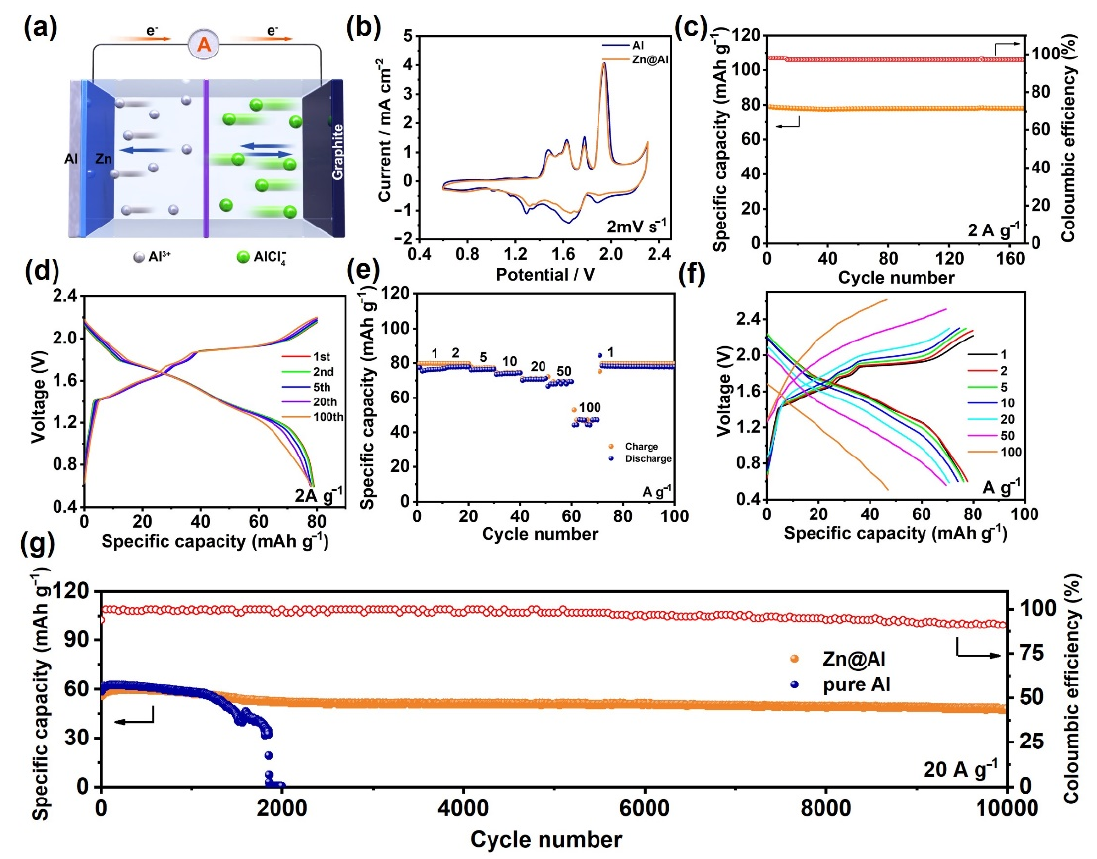
Figure 3. Electrochemical performances of Zn@Al–graphite and Al–graphite cells: ( a ) Working diagram of full battery. ( b ) CV curves in full battery at a scan rate of 2 mV·s − 1 . ( c ) Cycling stability ( d ) and charge/discharge curves of Zn@Al–graphite full battery at 2 A·g − 1 . ( e ) Rate performance and ( f ) charge/discharge curves of Zn@Al–graphite cell at various currents from 1 A·g − 1 to 100 A·g − 1 . ( g ) Cycling stability in Zn@Al–graphite and Al–graphite cells at 20 A·g − 1 .